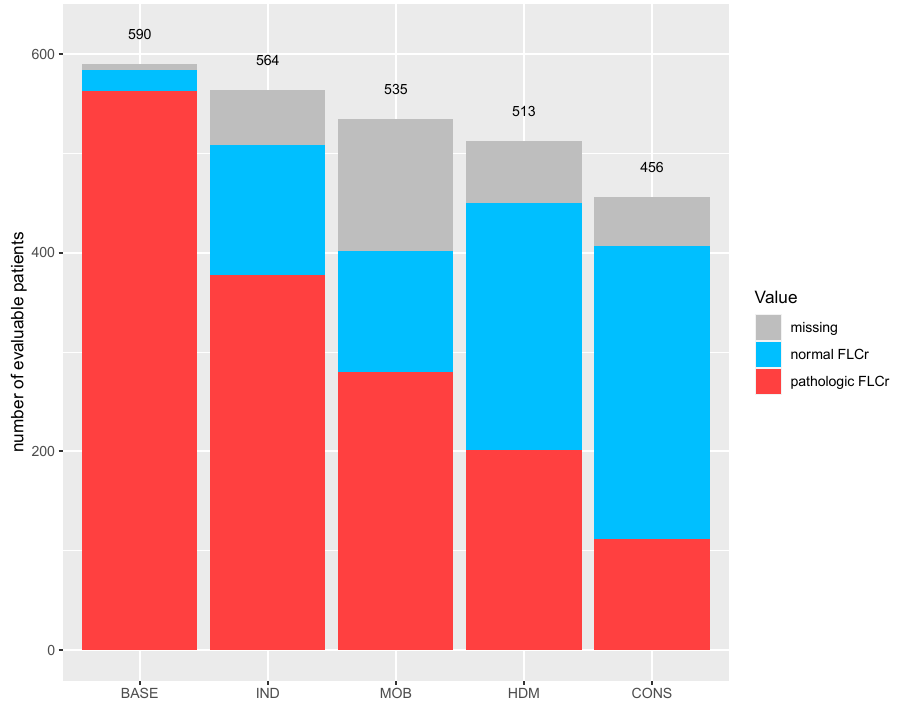
Figure 2. FLCr normalization during first-line therapy in the MM5 trial. The number of evaluable patients is represented by the number of patients on study at the start of each treatment phase.